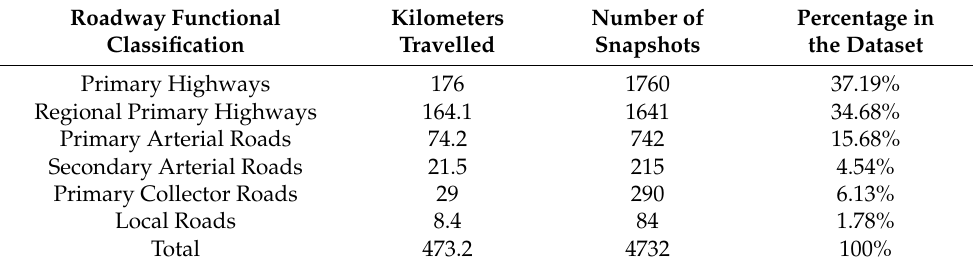
Figure 5. Data collection design in the Greater Cairo Region (GCR). Table 2. Distances covered and number of snapshots for each road functional